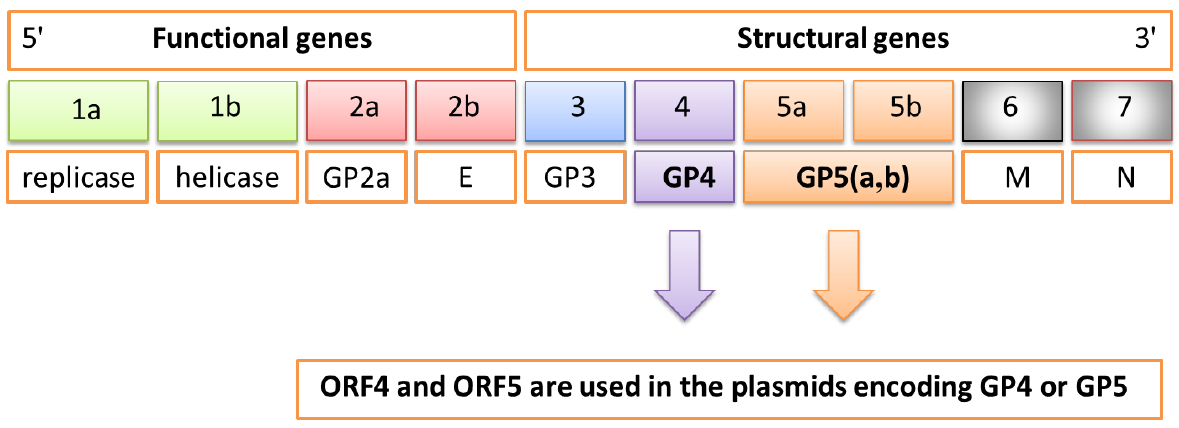
Figure 1. Schematic genome of porcine reproductive and respiratory syndrome virus (PRRSV) composed of 10 open reading frames (ORFs) encoding the different functional and structural proteins. In particular, ORF4 and ORF5 are used in the plasmid encoding GP4 or GP5